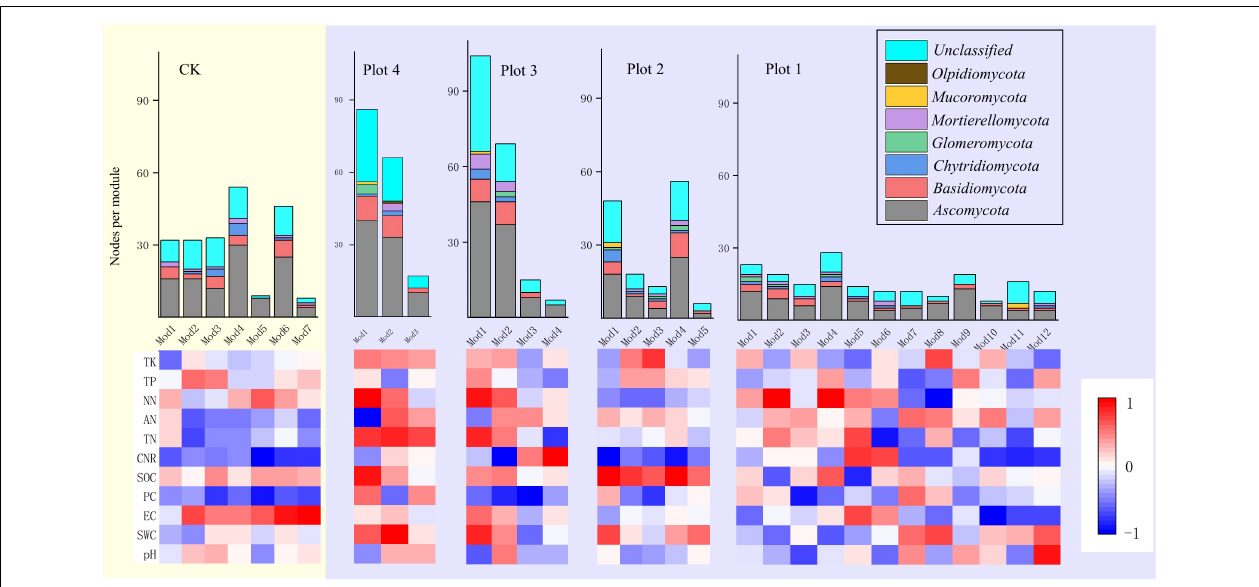
FIGURE 6 | Heat map of correlation between soil parameters and eigenvalues of soil fungal molecular ecological network modules (number of nodes > 5) with node taxonomy for different reclamation ages. Red represents positive correlation, blue represents negative correlation, and the histogram shows the number of nodes in each module and the phylum they belong